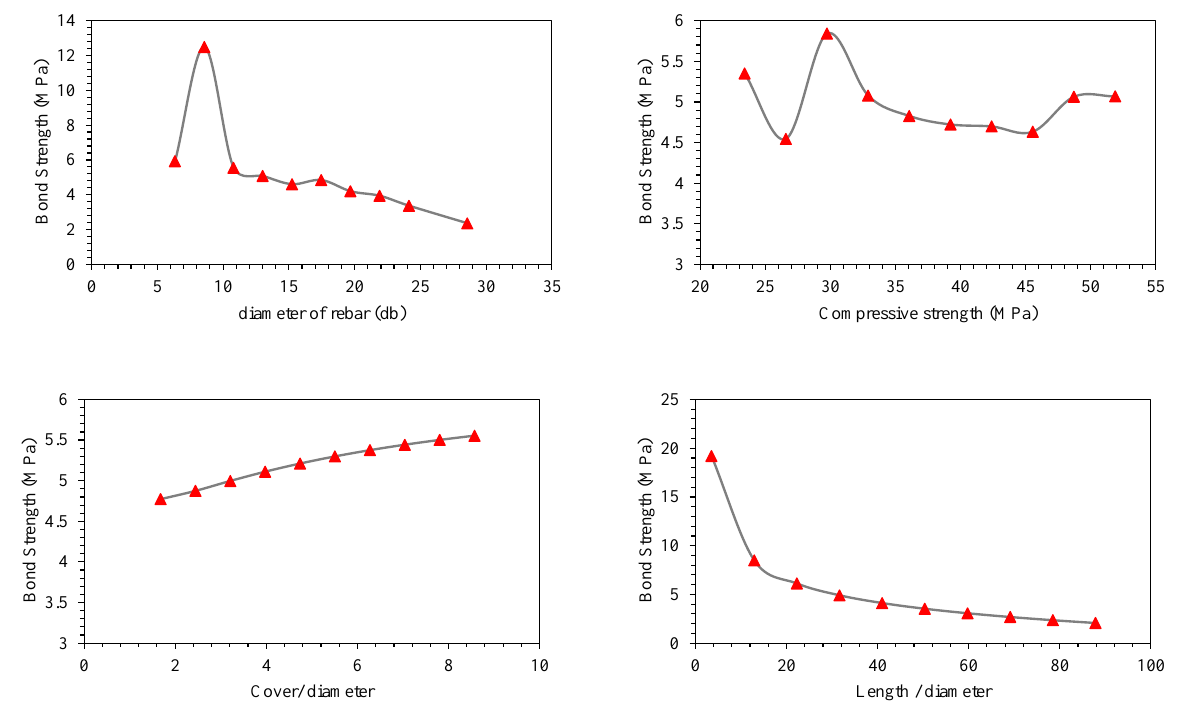
Figure 16. Effect of the contributing parameters on BS for B p type-II and B s type III.